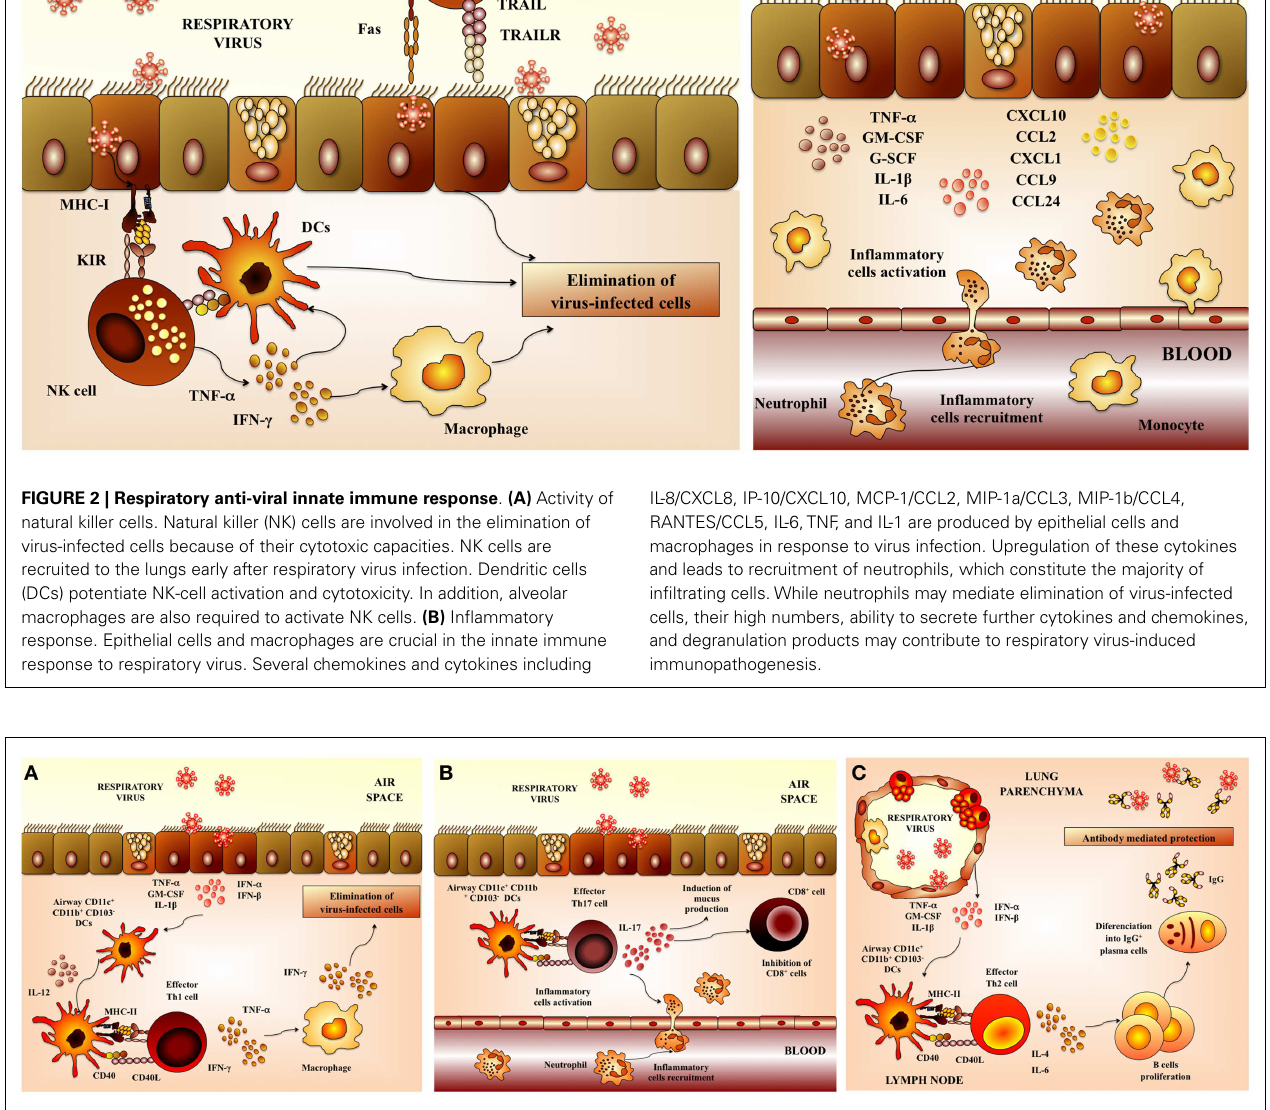
changes in the respiratory tract induce neutrophils recruitment and activate inflammatory responses in the lung. (C) Antibody-mediated immunity. Neutralizing antibodies have a critical role in protection from respiratory virus infection. Serum antibodies, mainly composed of IgG, gain access to the lungs via transduction and provide partial or complete protection against virus replication in the